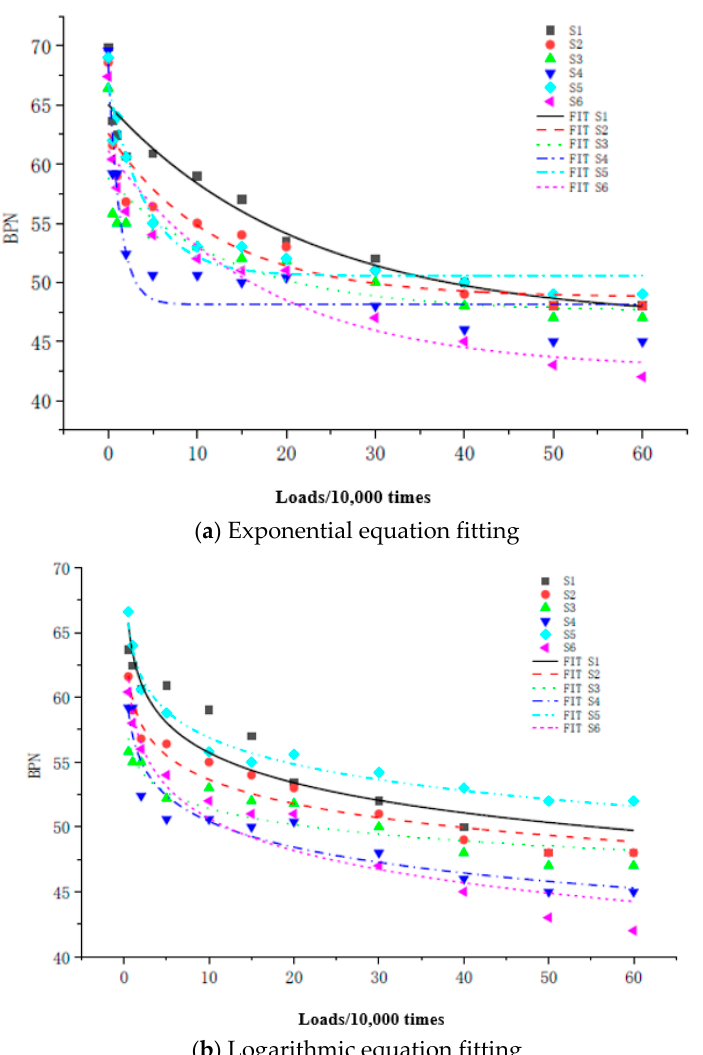
Figure 9. Pendulum friction coefficient attenuation fitting curve